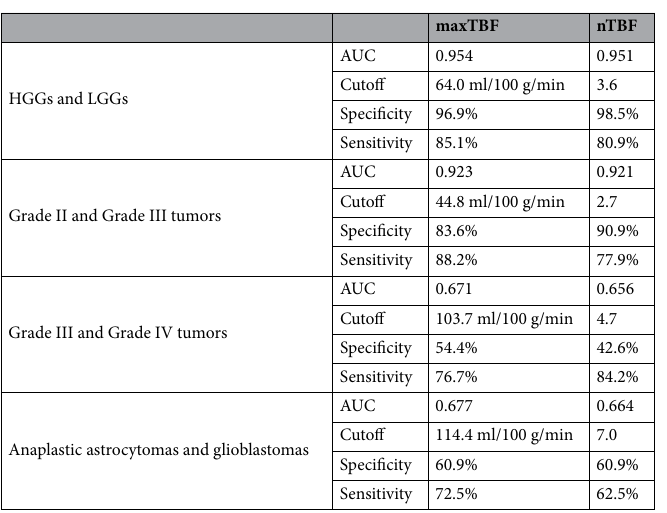
Table 3. ROC-analysis of maxTBF and nTBF in differential diagnosis of brain gliomas.